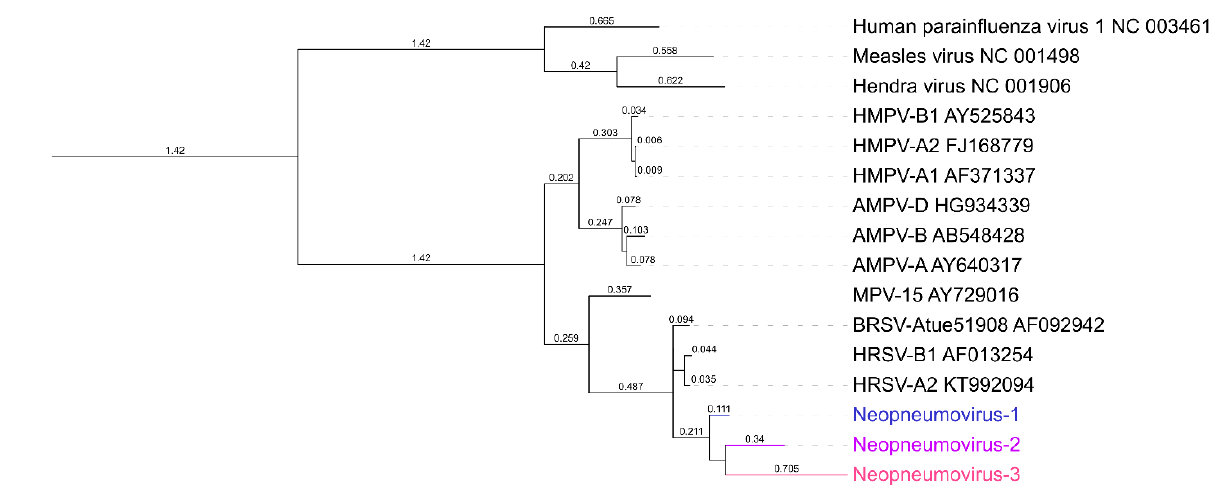
Figure 3. Phylogeny of Neopneumoviruses. Protein sequences of the polymerases were aligned with MAFFT v7.450, and the phylogeny was reconstructed with IQtree 2.0.6 with model of substitution JTT + F + G4. The resulting tree was rooted using members of the Paramyxoviridae family as outgroup. AMPV: Avian metapneumovirus; HMPV: Human metapneumovirus; MPV: Murine orthopneumovirus; BRSV: Bovine orthopneumovirus; HSRV: Human respiratory syncytial virus. Accession numbers are indicated in the figure. Numbers on the branches represent their lengths.